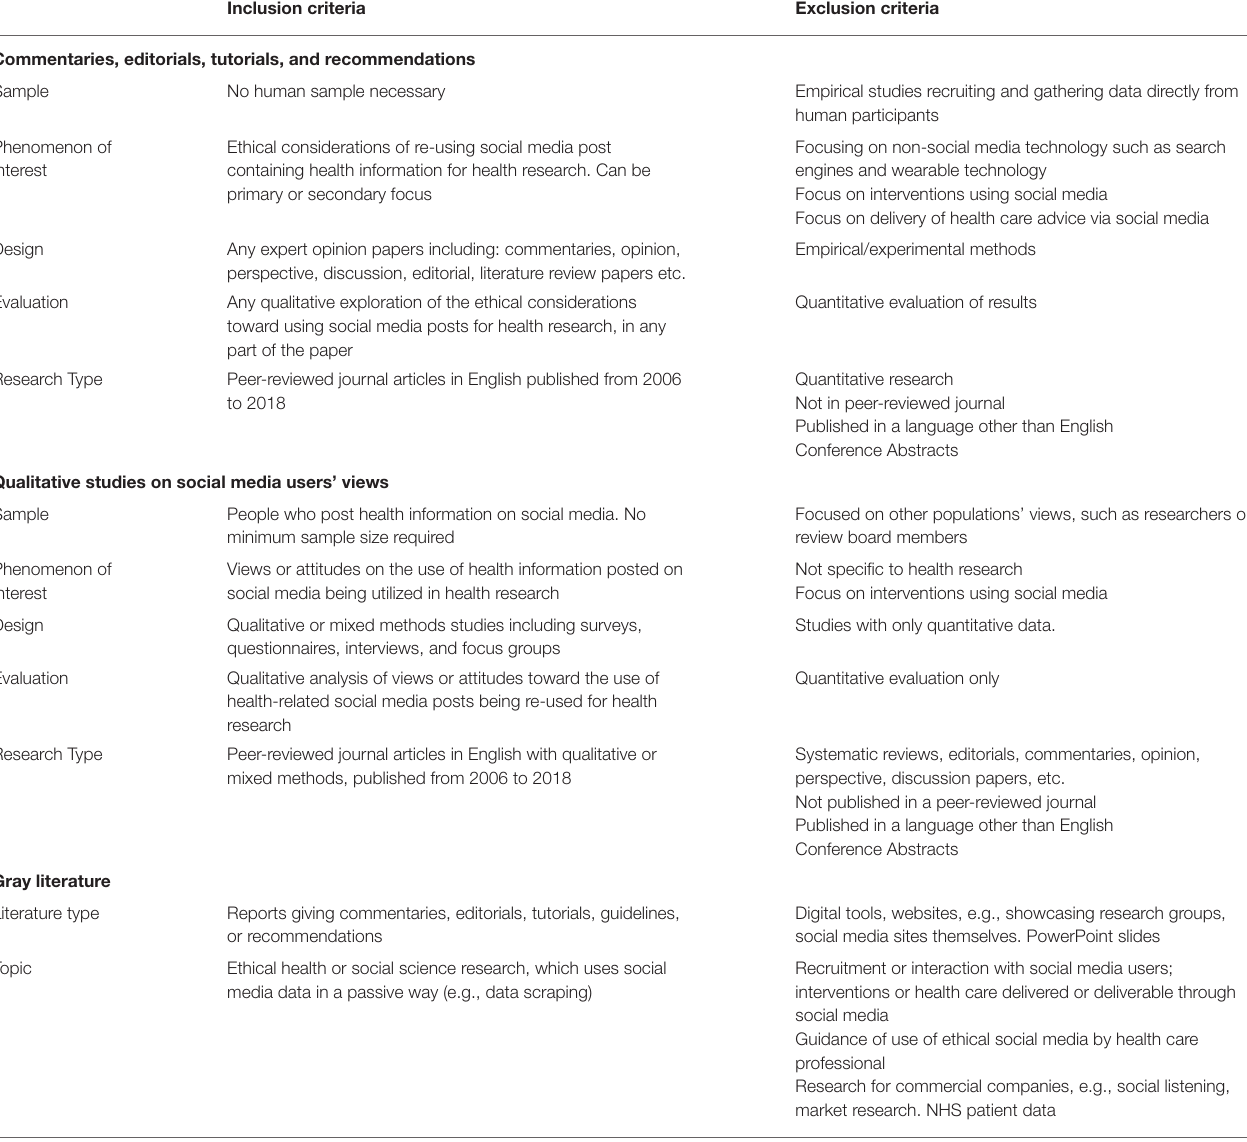
TABLE 2 | Inclusion and exclusion criteria for systematic review using the SPIDER